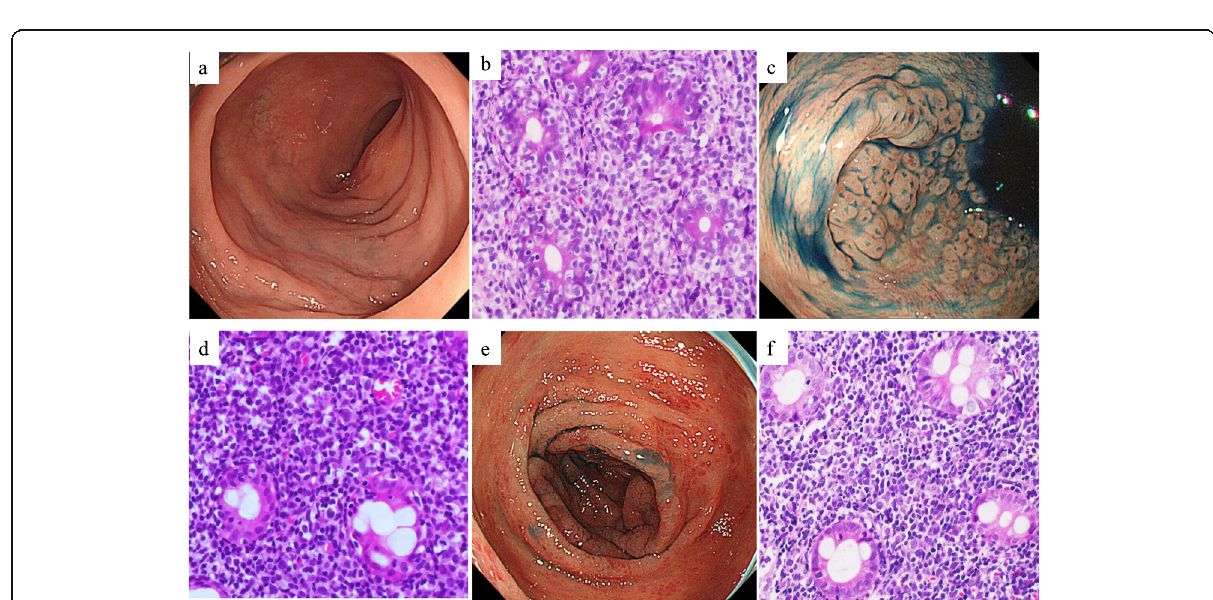
Fig. 2 Endoscopic and histologic findings of diffusely infiltrating type MEITL (a, b) and ATLL (c-f). a Endoscopic view of sigmoid colon showing mild edematous mucosa with small erosion. b Histological analysis showing small nests of atypical intraepithelial lymphocytes (IELs), preserved glands, and invasion by medium-sized atypical lymphocytes (hematoxylin and eosin stain, × 400). c Endoscopic view of cecum showing many aphthoid colitis-like lesions. d Histological analysis showing preserved glands, small nests of atypical IELs, and invasion by pleomorphic medium- sized atypical lymphocytes, × 400. e Endoscopic view of the descending colon showing reddish, mildly edematous mucosa. f Histological analysis showing invasion by small and medium-sized atypical lymphocytes, ×